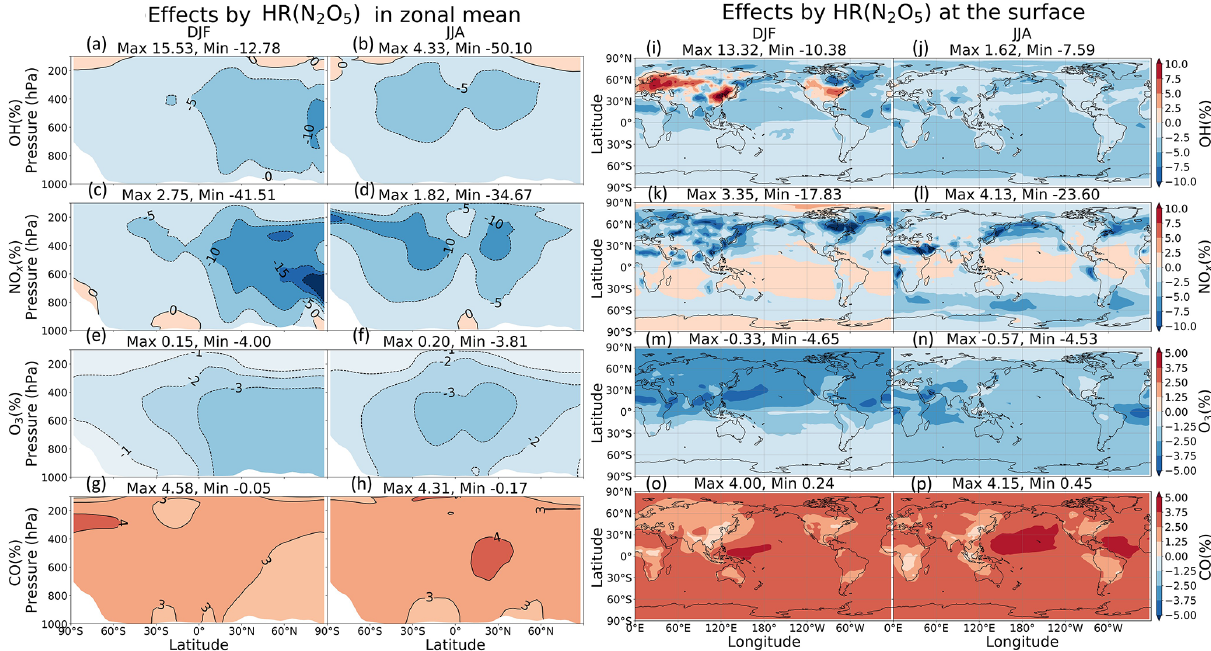
Figure 9. Effects by N 2 O 5 uptake onto both clouds and aerosols in zonal mean (a–h) and at the surface (i–p) . Note that the color scale for (a) – (h) is different from that for (i) – (p)